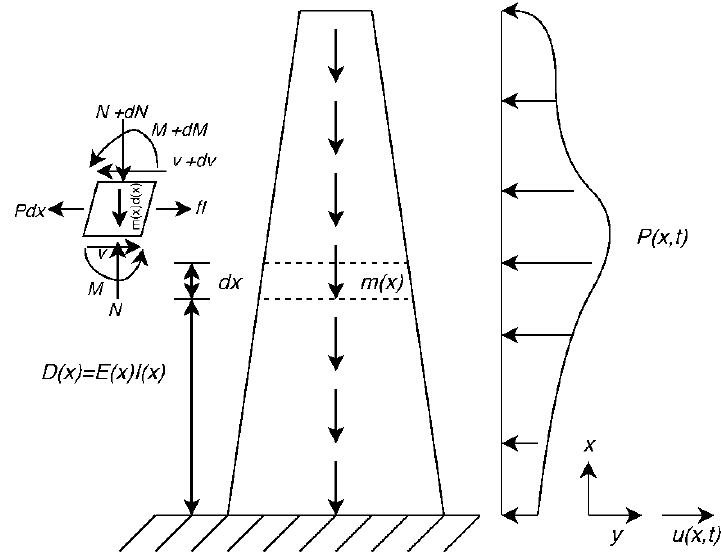
Figure 1. Schematic cantilever column without damping subjected to an external variable load.